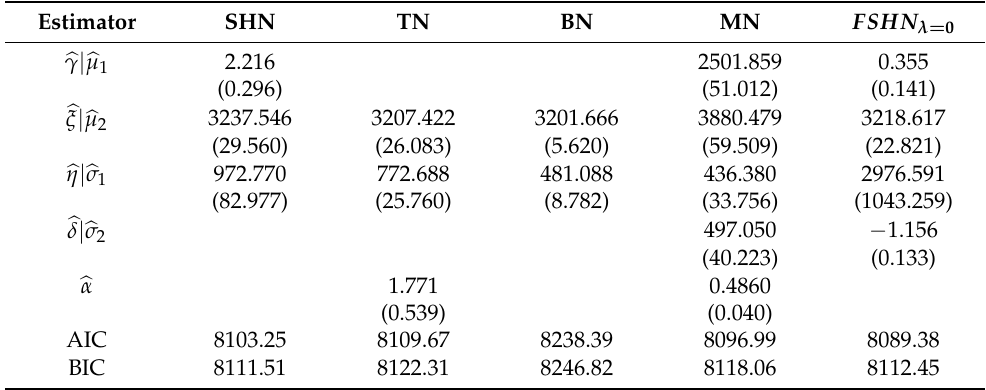
Table 3. Estimates of parameters, (standard errors) in models fitted in Dataset